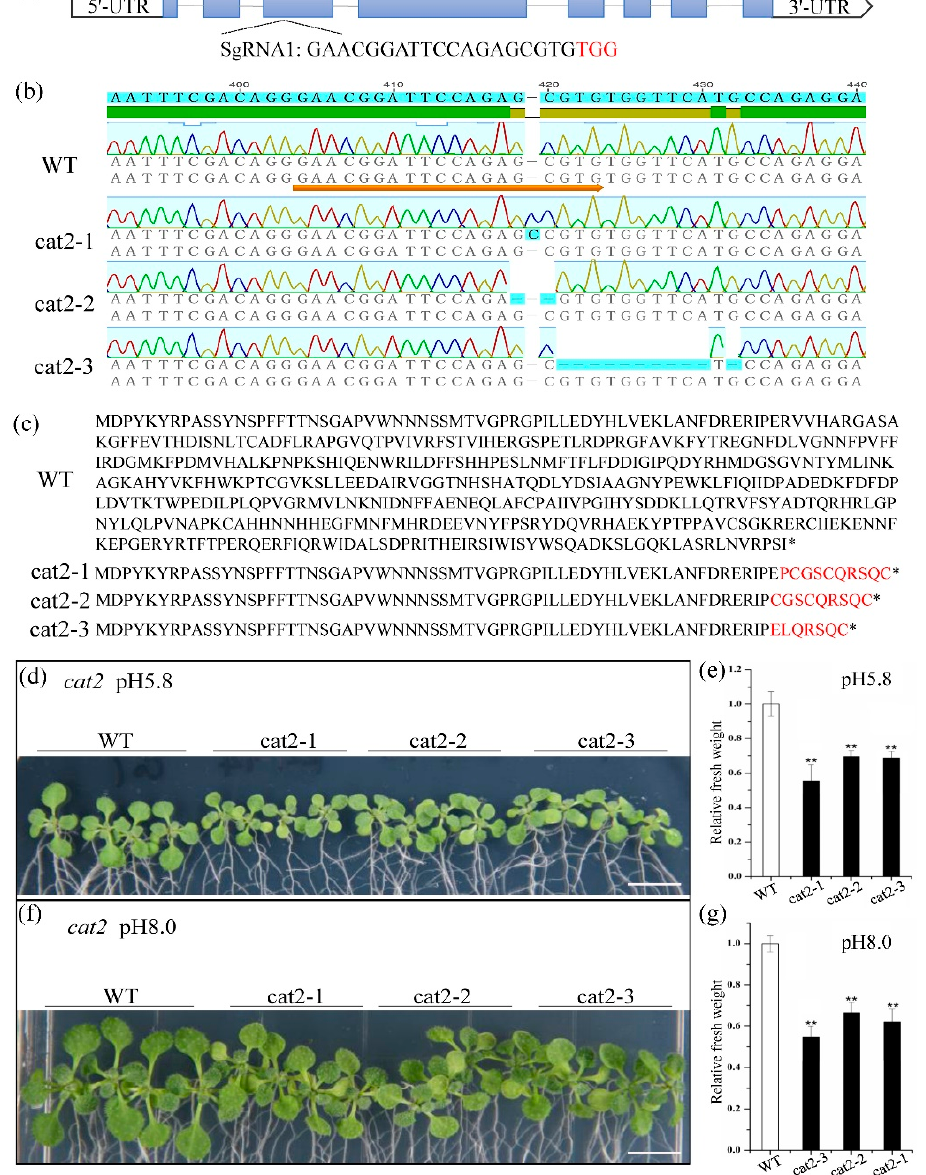
Figure 5. Phenotypic analysis of CAT2 -CRISPR lines. ( a ) The target site disrupts the third exon of CAT2 . The red arrows show target sites. ( b ) Genomic of CAT2 from WT and mutants cat2-1, cat2-2, and cat2-3 generated using CRISPR-Cas9 technology. ( c ) Polypeptide sequences comparison of the WT and the mutants, showing that CRISPR-Cas9 technology lead to truncations of CAT2 protein. * Stop codon. ( d , f ) Phenotype of Col-0 , CRISPR lines, and WT seedlings grown on MS medium under pH 5.8 and 8.0, respectively. ( e , g ) Fresh shoot weight of Col-0 and CRISPR lines seedlings germinated and grown on MS medium under pH 5.8 and 8.0, respectively. Data are given as means ± SE of five biological replicates. * and ** represent significant difference at the 5% and 1% levels, respectively.